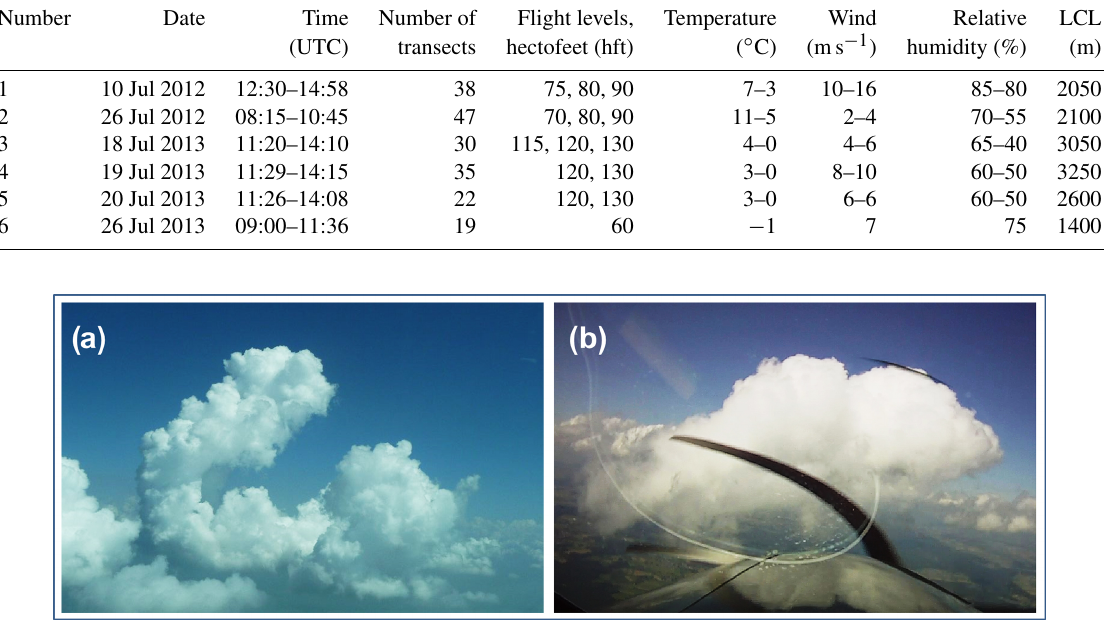
Figure 2. Examples of clouds in weak and strong shear environments. (a) Cloud in weak-wind weak-shear environment during flight 2. It has a common cloud base but cloud gaps in the upper part, which is surrounded by drier air, rh ≈ 60%. Weak winds blow in the lower cloud part with ≈ 2–4ms − 1 , the inclination of the cloud top indicates increasing wind with height. (b) Cloud in a boundary layer with strong wind shear during flight 1 immediately before a crosswind transect. The wind blows from the left and the shear-induced declination of the cloud is visible. The cloud bottom does not show a sharp line, which indicates that the cloud has reached at least a mature state, without a strong updraught in the lower cloud